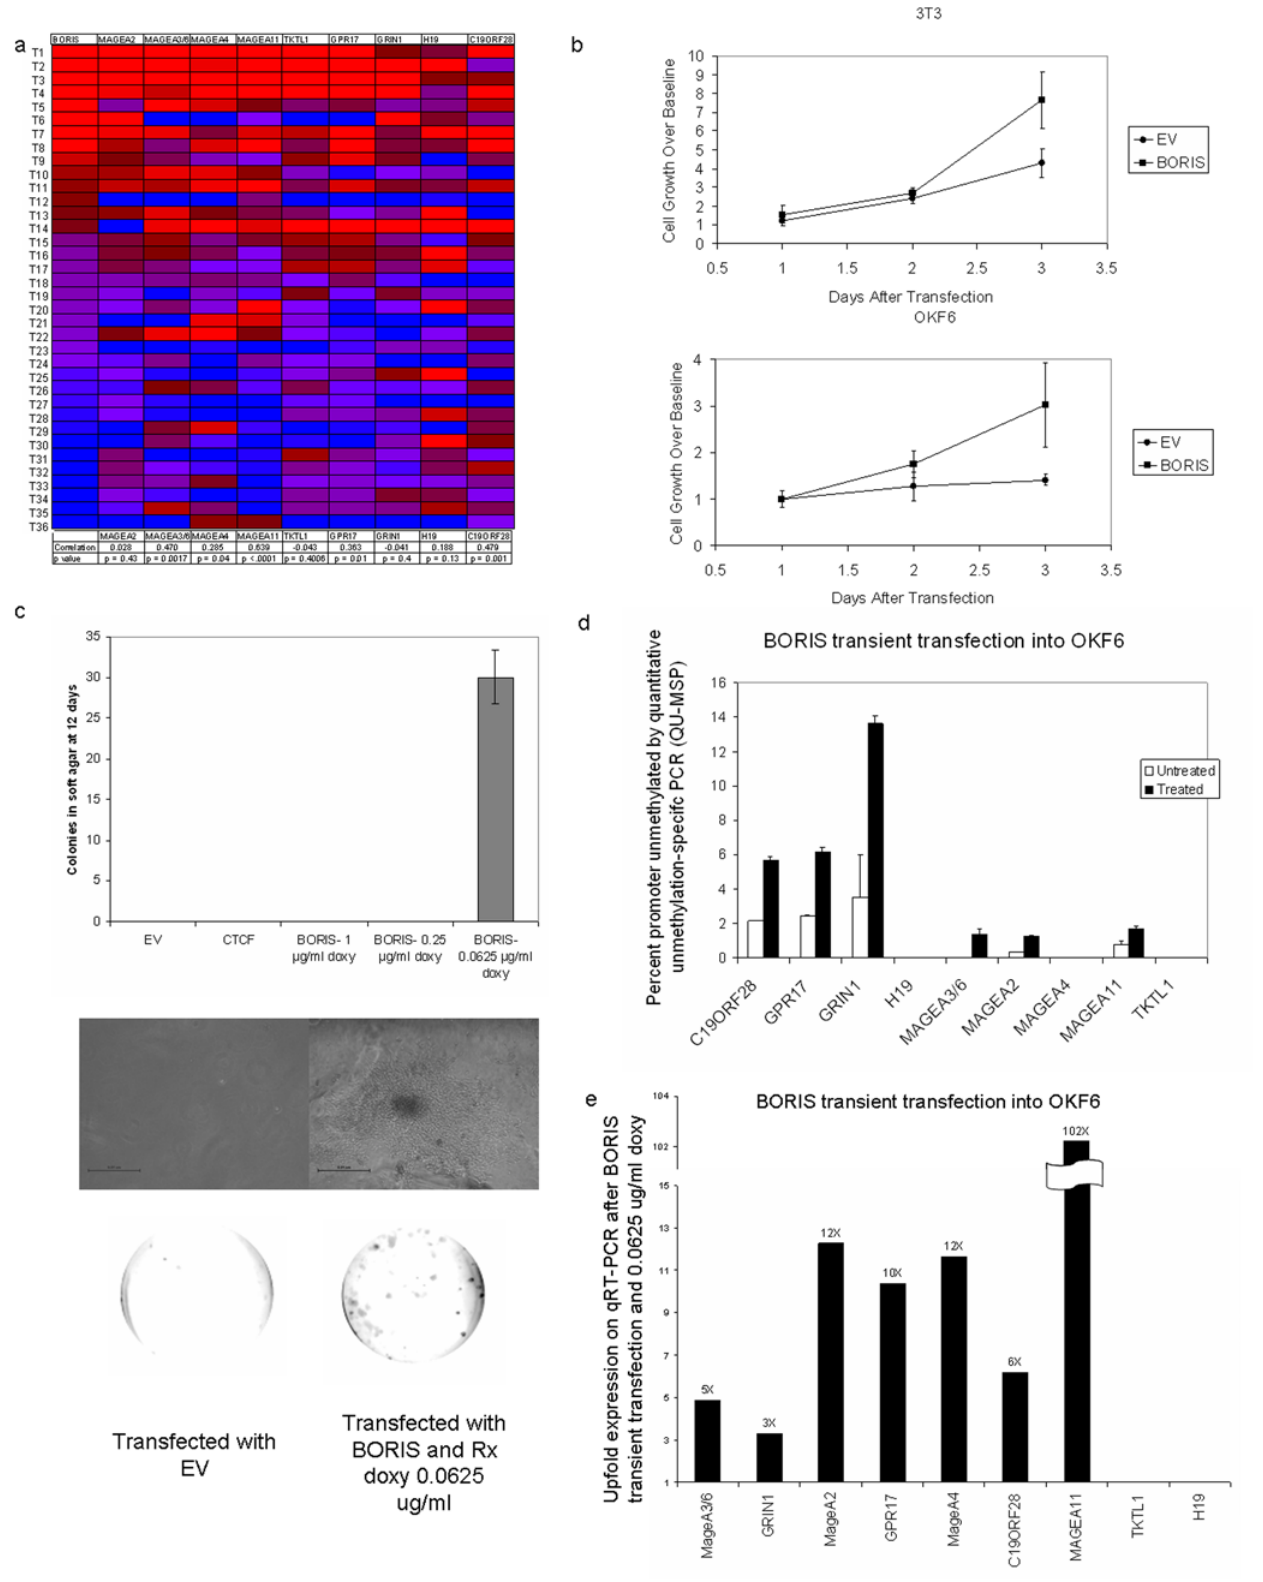
Figure 7. BORIS transfection studies. ( a ) BORIS expression correlates with expression of target genes in HNSCC (QRT-PR) heat map (Pearson correlation) ( b ) Transient transfection of BORIS construct into NIH-3T3 and OKF6-Tert1R cell lines. BORIS overexpression resulted in increased cell growth in the 3T3 cell line (at day 3, 77% 6 34% growth increase) and in the OKF6-Tert1R cell line (at day 3, 161% 6 78% growth increase). Cell growth